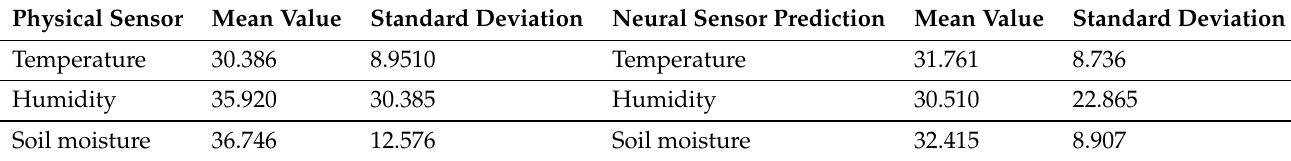
Table 4. Mean and Standard deviation of physical sensor and neural sensor values.